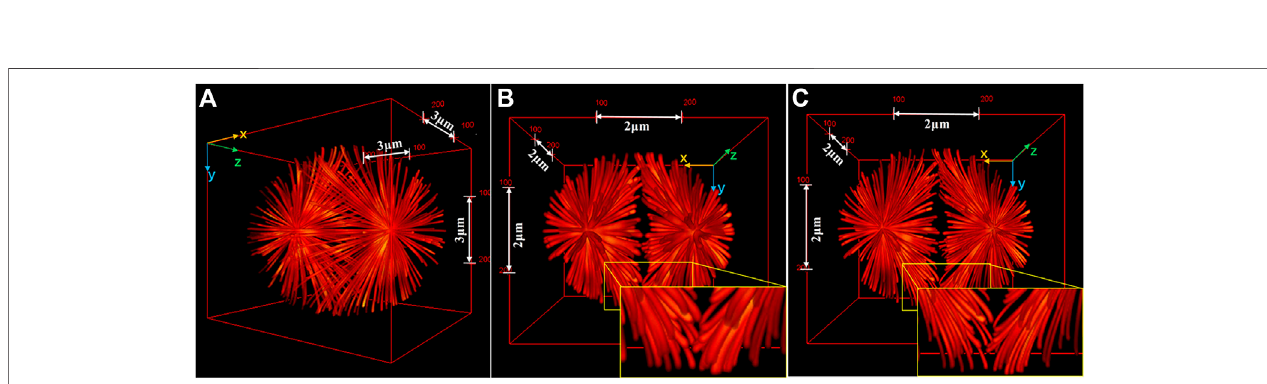
FIGURE 5 | Comparison of 3D images of a complex sample reconstructed by I 5 S and SI 5 S. (A) Ground truth image. (B) and (C) 3D perspectives of the images reconstructedbyI 5 S (B) andSI 5 S (C) .TheimagereconstructedbySI 5 Sshowsmoredistinctstructures.Theinsetsshowexpansionsoftheyellowoutlinedregionsofthe images. Figures are modi fi ed with permission from Ref. 36. Copyright © 2020